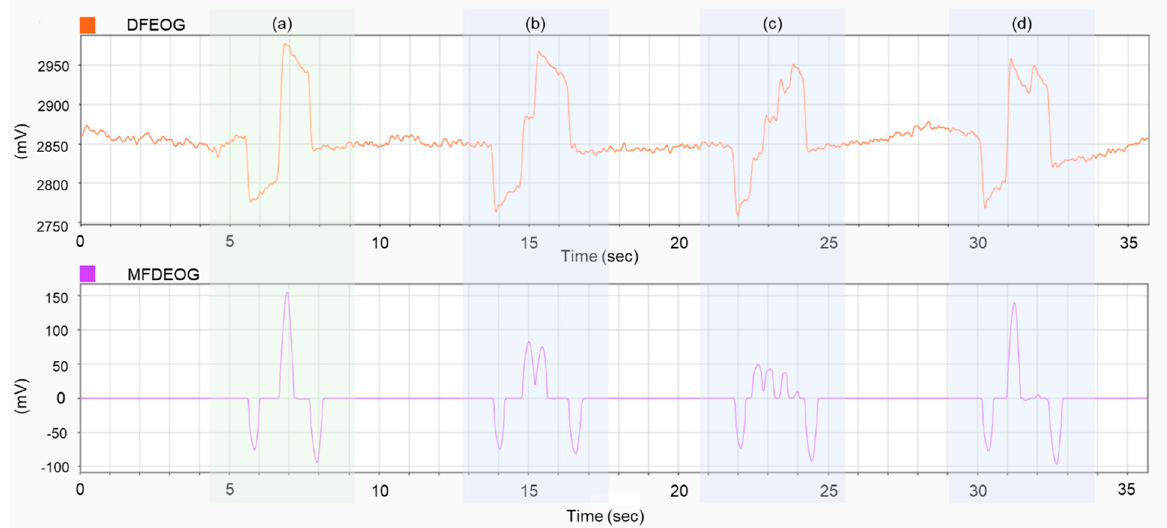
Figure 17. Example of repeated eye movements of L40-R80-L40: ( a ) normal eye movement with three peaks of MFDEOG; ( b – d ) abnormal eye movements with more than three peaks of